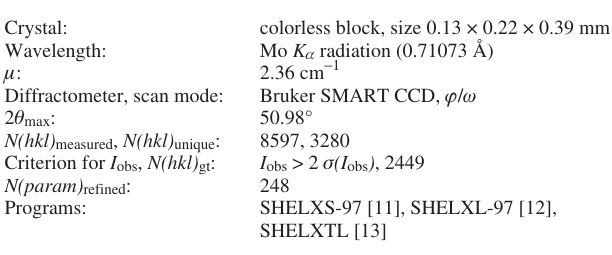
Table 1. Data collection and